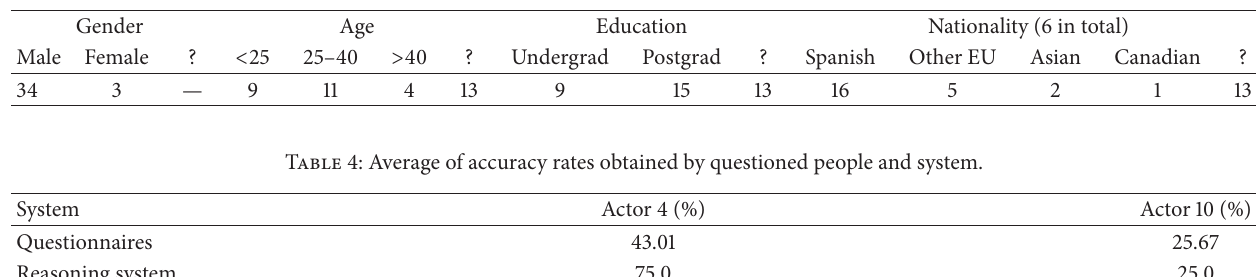
Table 3: Participants information.